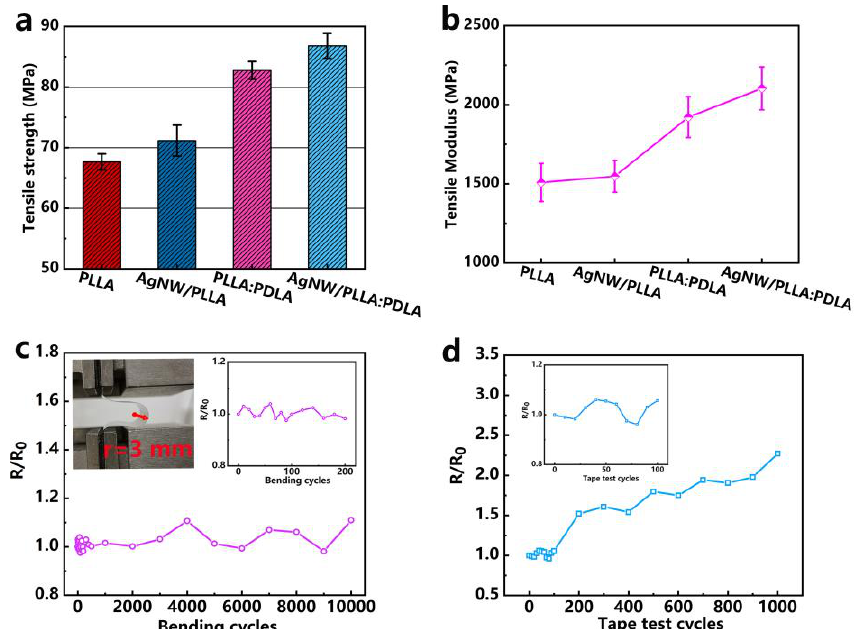
Figure 4. ( a ) Tensile strength and ( b ) tensile modulus of the PLLA, AgNW/PLLA, PLLA:PDLA, and AgNW/PLLA:PDLA films. ( c ) The bent state of the film with the radius of 3 mm, R/R 0 of the AgNW/PLLA:PDLA film during bending test. ( d ) R/R 0 of the AgNW/PLLA:PDLA film at different adhesion testing cycles with 3M scotch tape. R is the real-time sheet resistance and R 0 is the initial sheet resistance of the AgNW/PLLA:PDLA film.